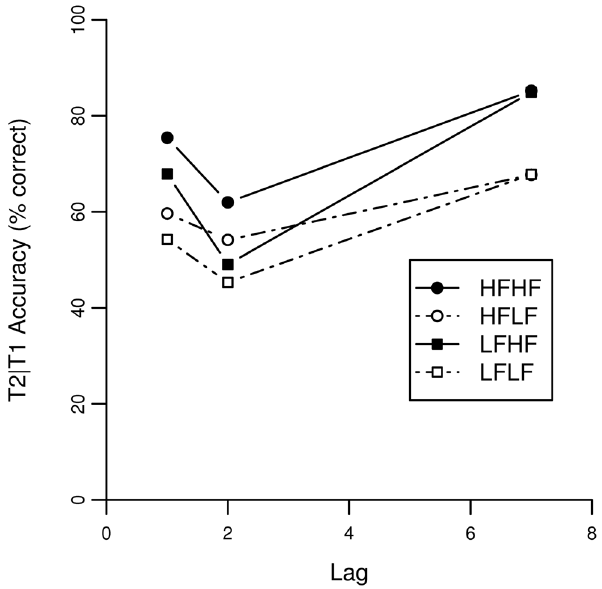
Figure 6. Accuracy scores of the AB task for T1 in Experiment 2. The lag corresponds to the temporal location of T2 relative to T1.